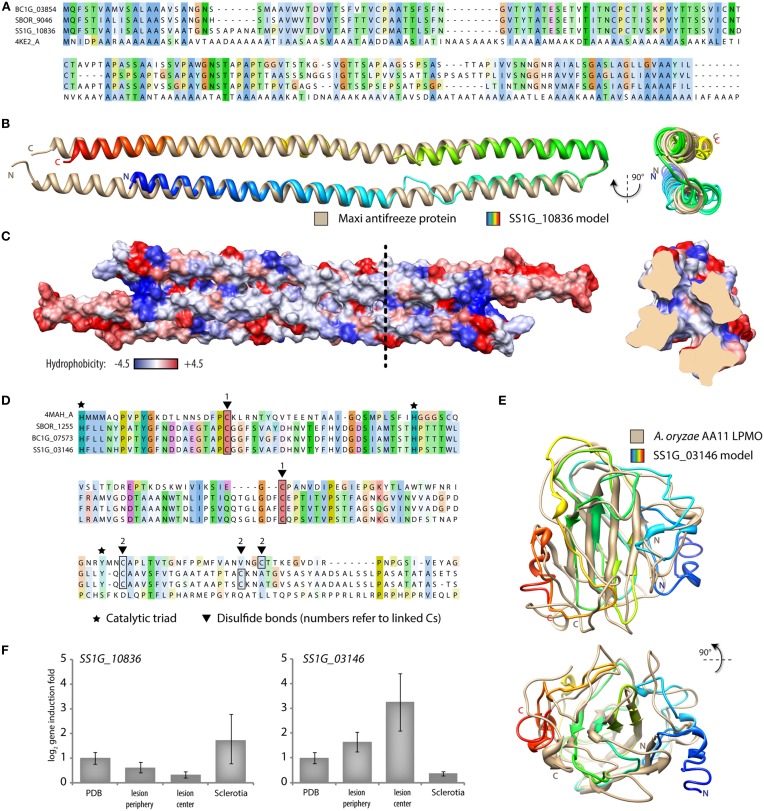
Candidate proteins associated with colonization of the environment identified based on high sTEKhot values. (A) Multiple protein sequence alignment of B. cinerea BC1G_03854 (sTEKhot = 4.29), S. borealis SBOR_9046 (sTEKhot = 10.01), S. sclerotiorum SS1G_10836 (sTEKhot = 7.34) and the hyperactive Type I antifreeze protein “Maxi” from Pseudopleuronectes americanus (4KE2_A). (B) Superimposition of Maxi antifreeze protein structure (tan) and SS1G_10836 model structure (rainbow). (C) Surface hydrophobicity of SS1G_10836 model dimer. Dotted line corresponds to the position of the section shown on the right, illustrating the characteristic hydrophilic inner core of the dimer. (D) Multiple protein sequence alignment of B. cinerea BC1G_07573 (sTEKhot = 7.07), S. borealis SBOR_1255 (sTEKhot = 3.79), S. sclerotiorum SS1G_03146 (sTEKhot = 1.58) and the AA11 Lytic Polysaccharide Monooxygenase from Aspergillus oryzae (4MAH_A). (E) Superimposition of A. oryzae AA11 structure (tan) and SS1G_03146 model structure (rainbow). (F)
SS1G_10836 and SS1G_03146 gene expression in vitro (PDB, Potato Dextrose Broth), during colonization of Arabidopsis thaliana (lesion periphery and lesion center) and in sclerotia. Error bars show standard error of the mean from two independent biological replicates.